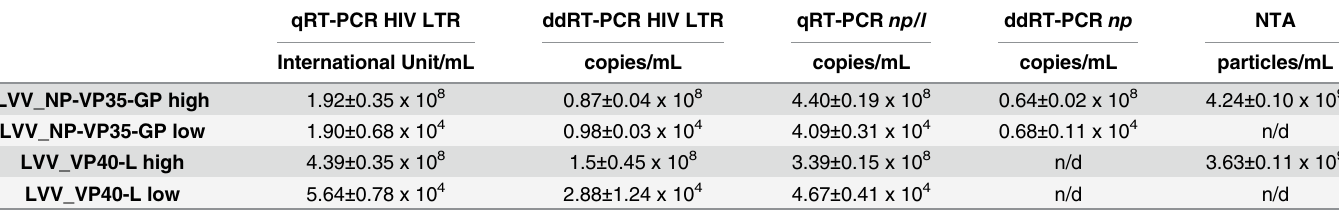
Table 3. Examples of the HIV-EBOV RNA standard values using different technologies.